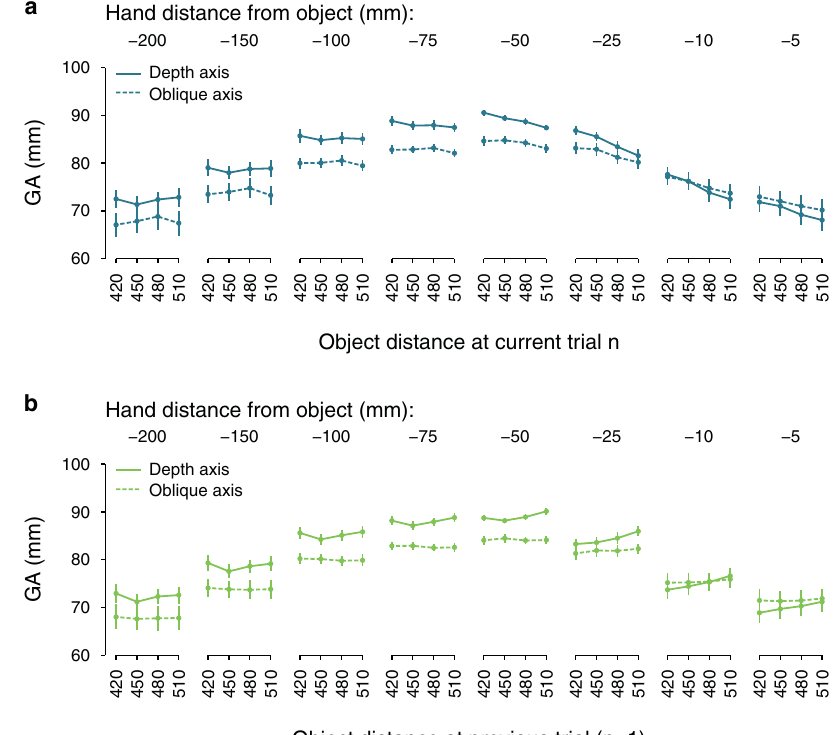
Figure 2. Distance effects on grip aperture. ( a ) Grip aperture (GA) as a function of the object’s distance at the current trial (dark blue lines). ( b ) Grip aperture (GA) as a function of the object’s distance at the previous trial (light green lines). Grasping was performed along the object’s depth axis (Experiment 1, continuous lines) or along the object’s oblique axis (Experiment 2, dashed lines). Separate panels represent the grip aperture when the hand was at different points of the movement path (the more negative values correspond to points of the movement path that are further away from the object). Error bars represent the standard error of the mean.